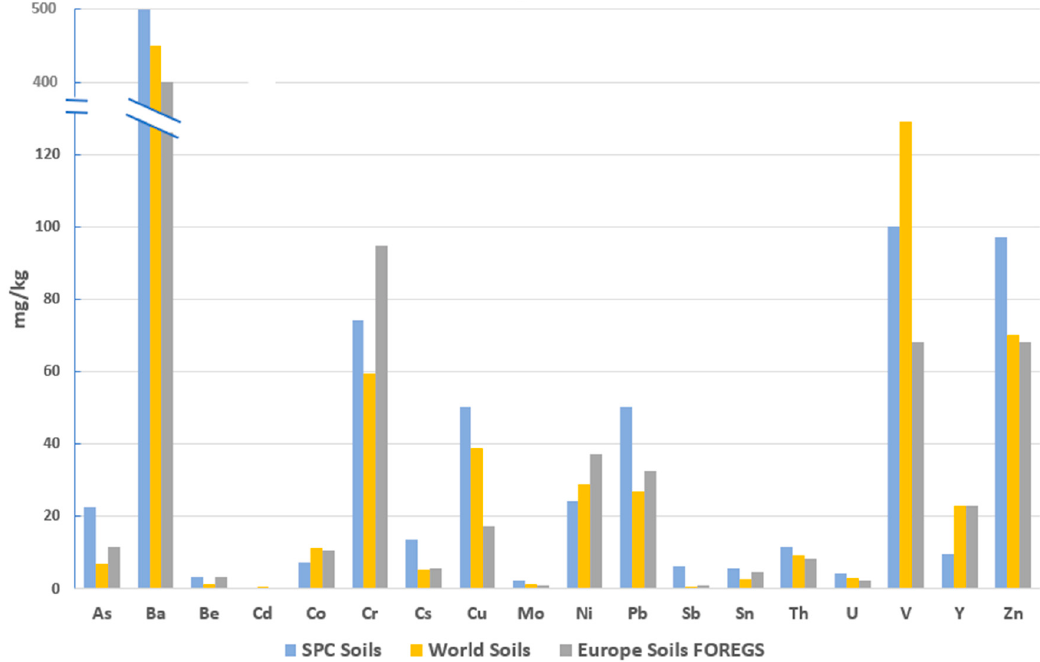
Figure 2 . Average trace elements concentration in the soils of São Pedro da Cova compared with the values of the world surface soils [26] and the European topsoils determined by the FOREGS programme [25].